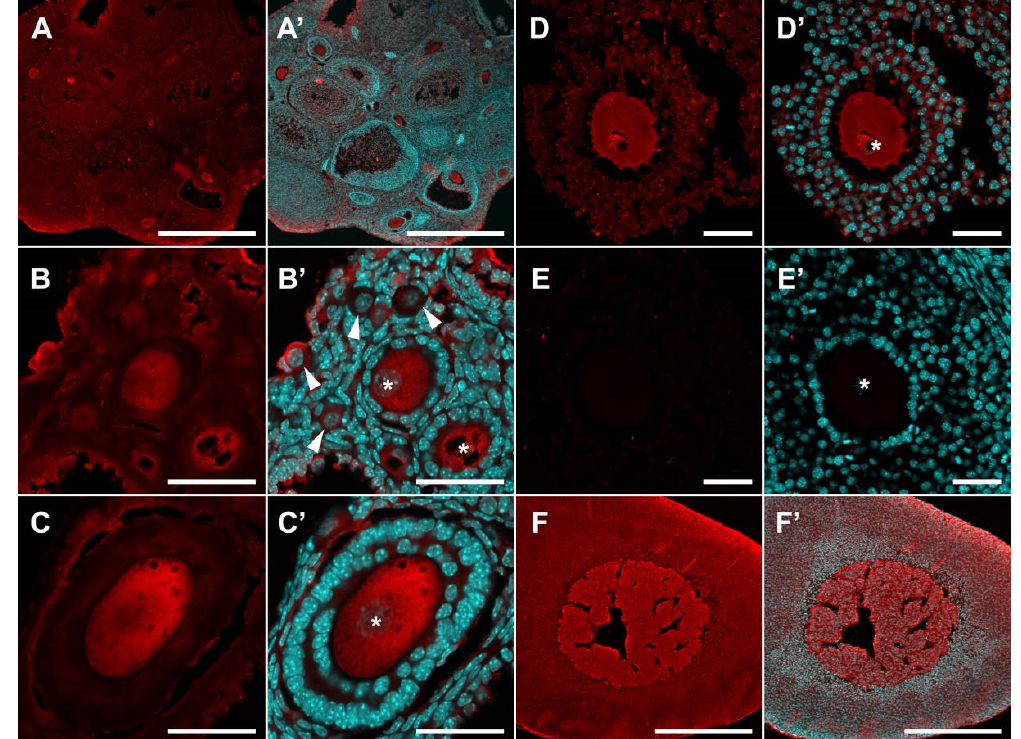
Figure 2. Immunohistochemical detection of SERT in the mouse ovary. ( A–D ) SERT immunoreactivity in the ovary of prepubertal ( B,C ) and adult mice ( A,D ). ( E ) Negative control: Ovary immunostaining without primary antibodies. ( F ) Positive control: Adrenal gland with SERT immunoreactivity in the medullar region. ( A’–F’ ) Images merged with nuclear staining. Twenty-μm cryosections were stained for SERT (red false colour) and nuclei were dyed with DAPI counterstain (cyan false colour). Arrowheads point to primordial follicles. Asterisks mark oocytes in growing follicles. Scale bars: ( A , F ) 500 µm; ( B – E ) 50 µm.